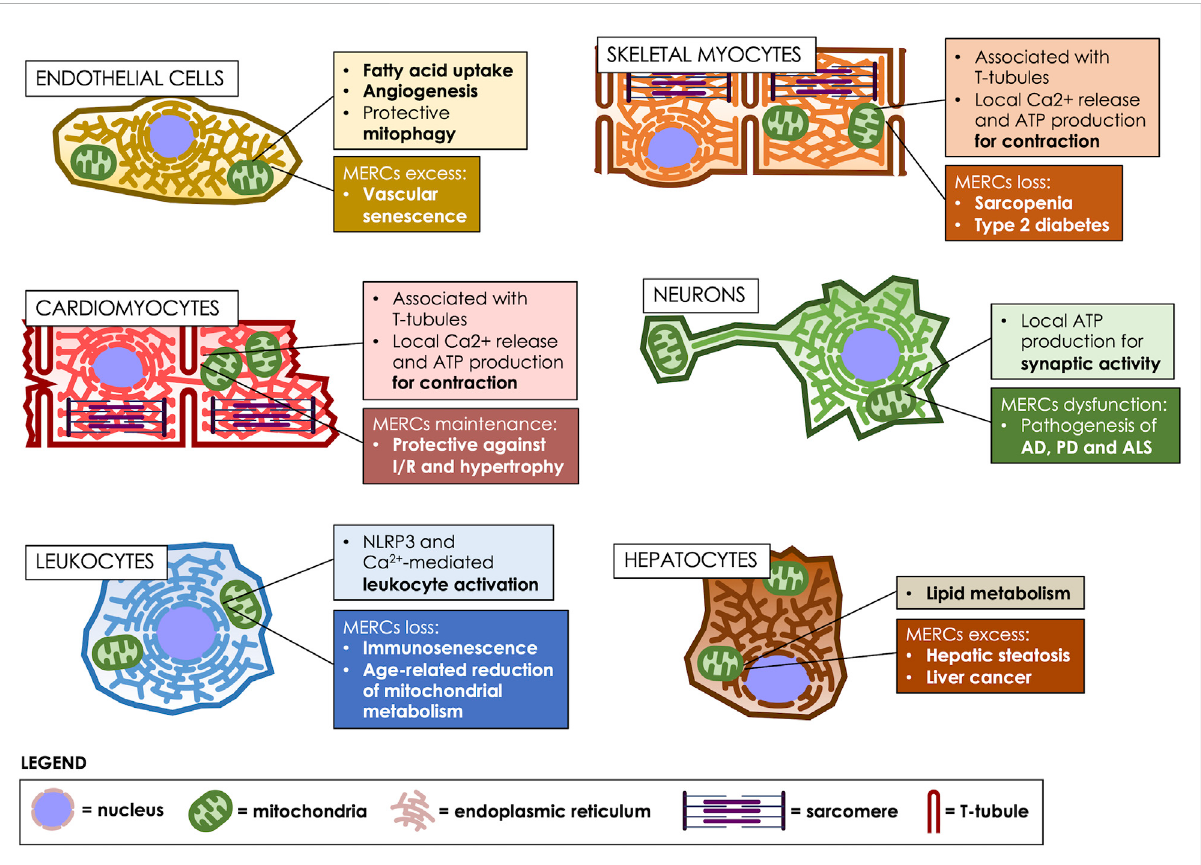
FIGURE 2 MERCs ful fi ll various roles, according to the cell type. MERCs differentiate both in structure and function, according to the cell ’ s differentiation state, participating in crucial processes such as motor, nervous, metabolic and immunological responses. Age-related changes inMERCsare heavily implicated in the development of multiple pathologies. T-tubules: transverse